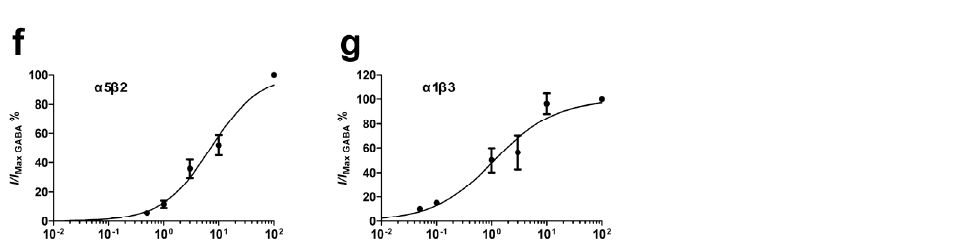
concentrations of GABA (0.01–100 µ mol / L) were estimated on di ff erent αβ receptors. Non-Linear